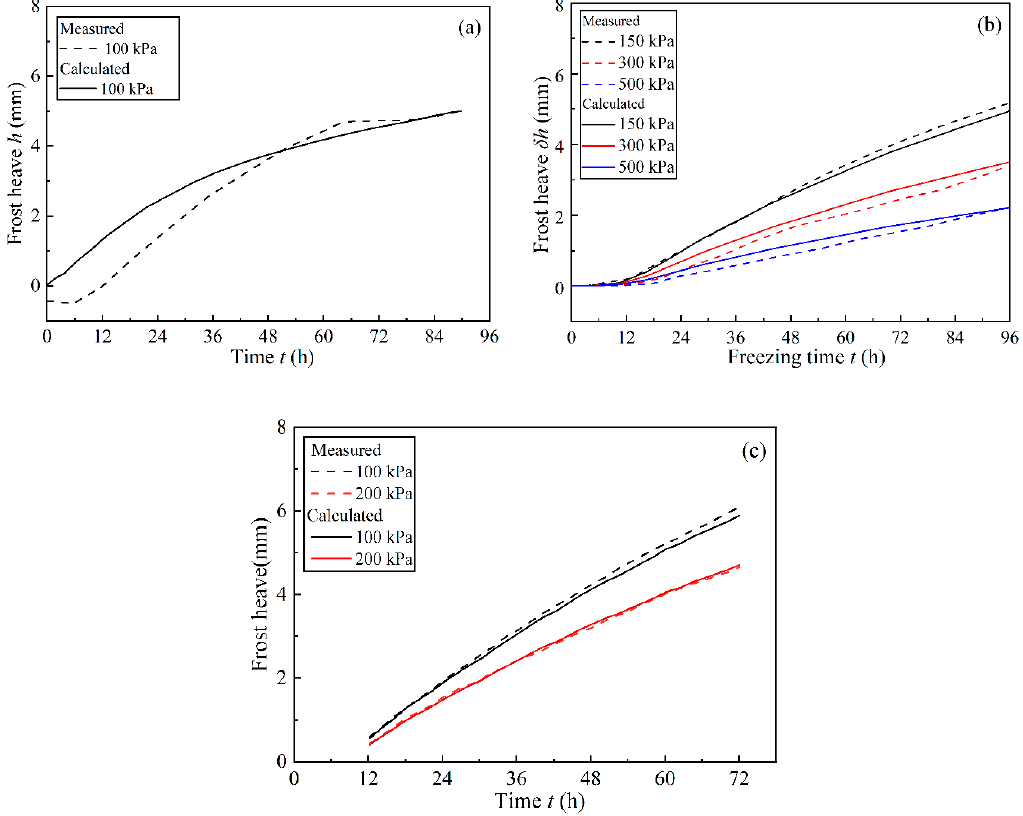
Figure 11. ( a ) Variation of frost heave under external load with the freezing time, ( b ) variation of final frost heave with the external pressure.